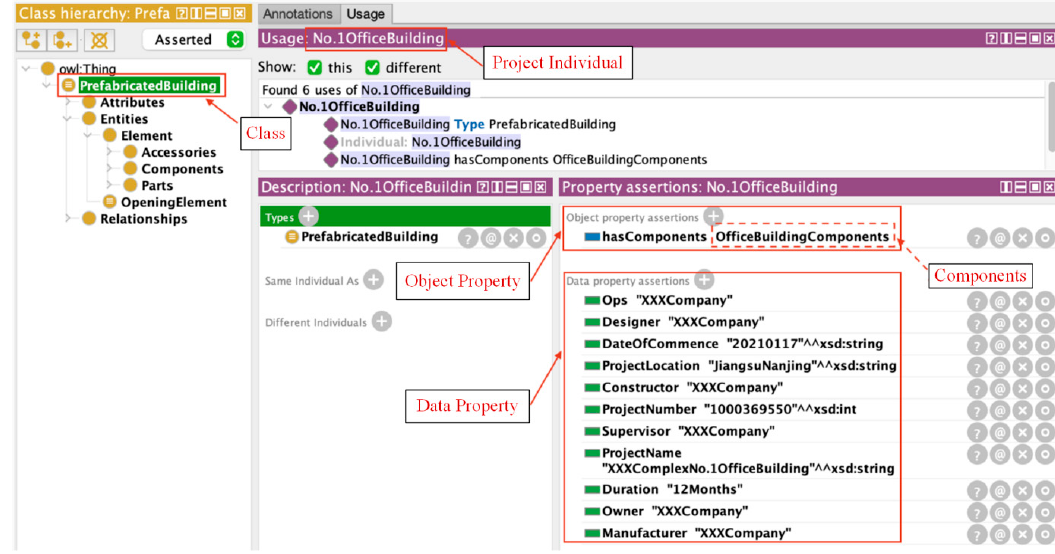
Figure 21. Project individual creation.